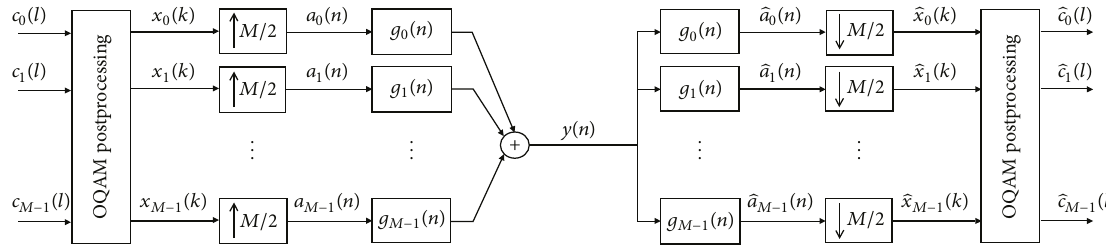
Figure 4: Basic representation of a FBMC-OQAM transmultiplexer. This scheme shows the basic idea behind FBMC-OQAM, where each symbol of each subchannel is modulated as OQAM, multiplied by its corresponding subcarrier, and filtered by the prototype filter. In the receiver, the inverse process is